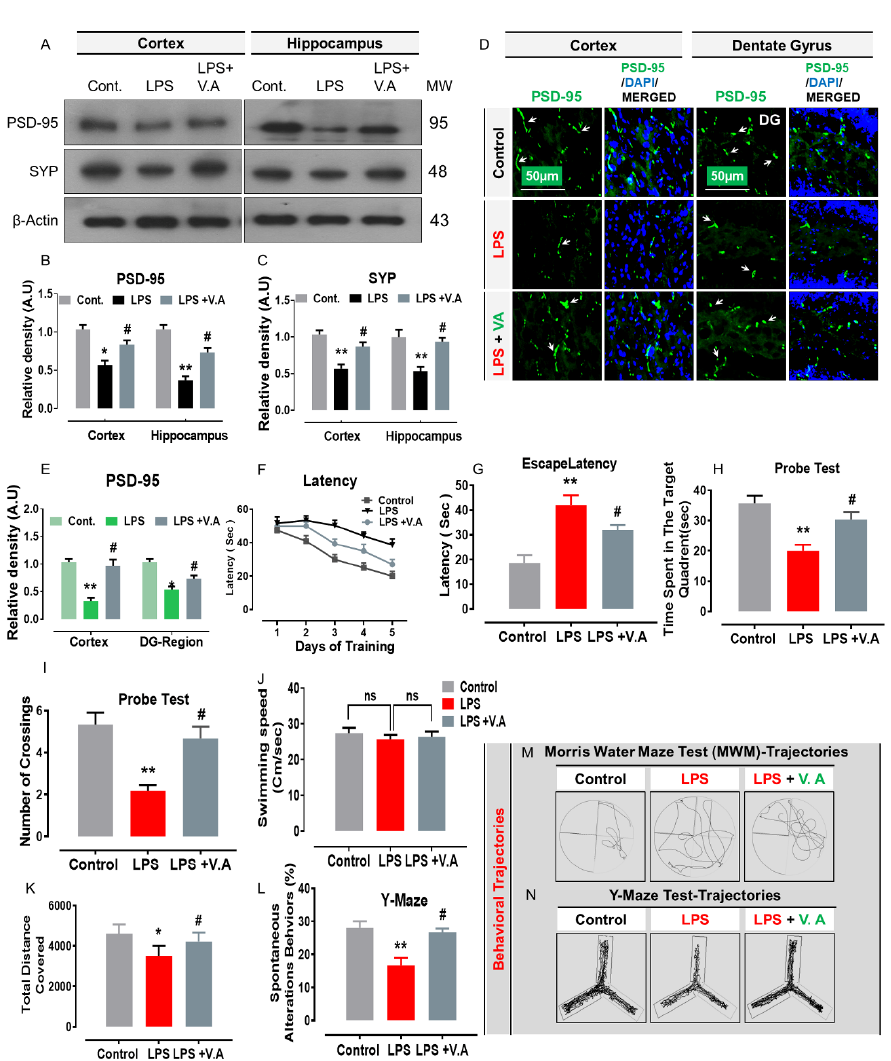
Figure 5. Vanillic acid treatment inhibited LPS-induced synaptic and memory dysfunction in mice brain. ( A – C ) the western blot bands of postsynaptic density proteins (PSD95), synaptophysin (SYP), antibodies along with their relative histograms indicating respective protein expression level in the cortex and hippocampus of mice brain. The western blot bands were cropped and quantified using ImageJ software, and the differences are shown in the histogram. The relative density values are expressed in comparison with control in A.U. All the values were taken as the mean ± SEM of three repeated/independent experiments for the respective indicated protein. As a loading control, an anti- β -actin antibody was used. n = 8 mice/group, and the number ( N ) of experiments performed = 3. ( D , E ) the representative photomicrographs of immunofluorescence staining represent the immunoreactivity of PSD95 in different regions (cortex and DG region) in various experimental brain groups (green, FITC; blue, DAPI). White small arrows indicated the desired signals of the tested antibody. The relative integrated density values were expressed in comparison with control arbitrary units (A.U). All values were taken as the means ( ± S.E.M) for the respective indicated proteins. For nucleus staining, DAPI (blue) was used. n = 8 mice/group, and the number ( N ) of experiments = N = 3. Magnification = 10 × . Scale bar; cortices/DG hippocampal regions = 50 µ m. Morris water maze (MWM) parameters are indicating ( F , G ) average escape latency (in a sec) and ( H ) probe test indicating time spent in target quadrant, ( I ) number of target crossings, and ( J ) Swim speed (cm/s) among the experimental groups. The Y-maze analysis represented ( K ) total distance covered (cm) and ( L ) spontaneous alteration behaviors. ( M , N ) indicating MWM and y-maze trajectories. For the behavioral study, the number of mice ( n = 16/experimental group) was used. Asterisk sign (*) indicated significant difference from the normal saline-treated (Cont.) group; hash sign (#) indicated significant difference from LPS-alone treated group. Significance: * # = p ≤ 0.05 and **= p ≤ 0.01. n.s = non